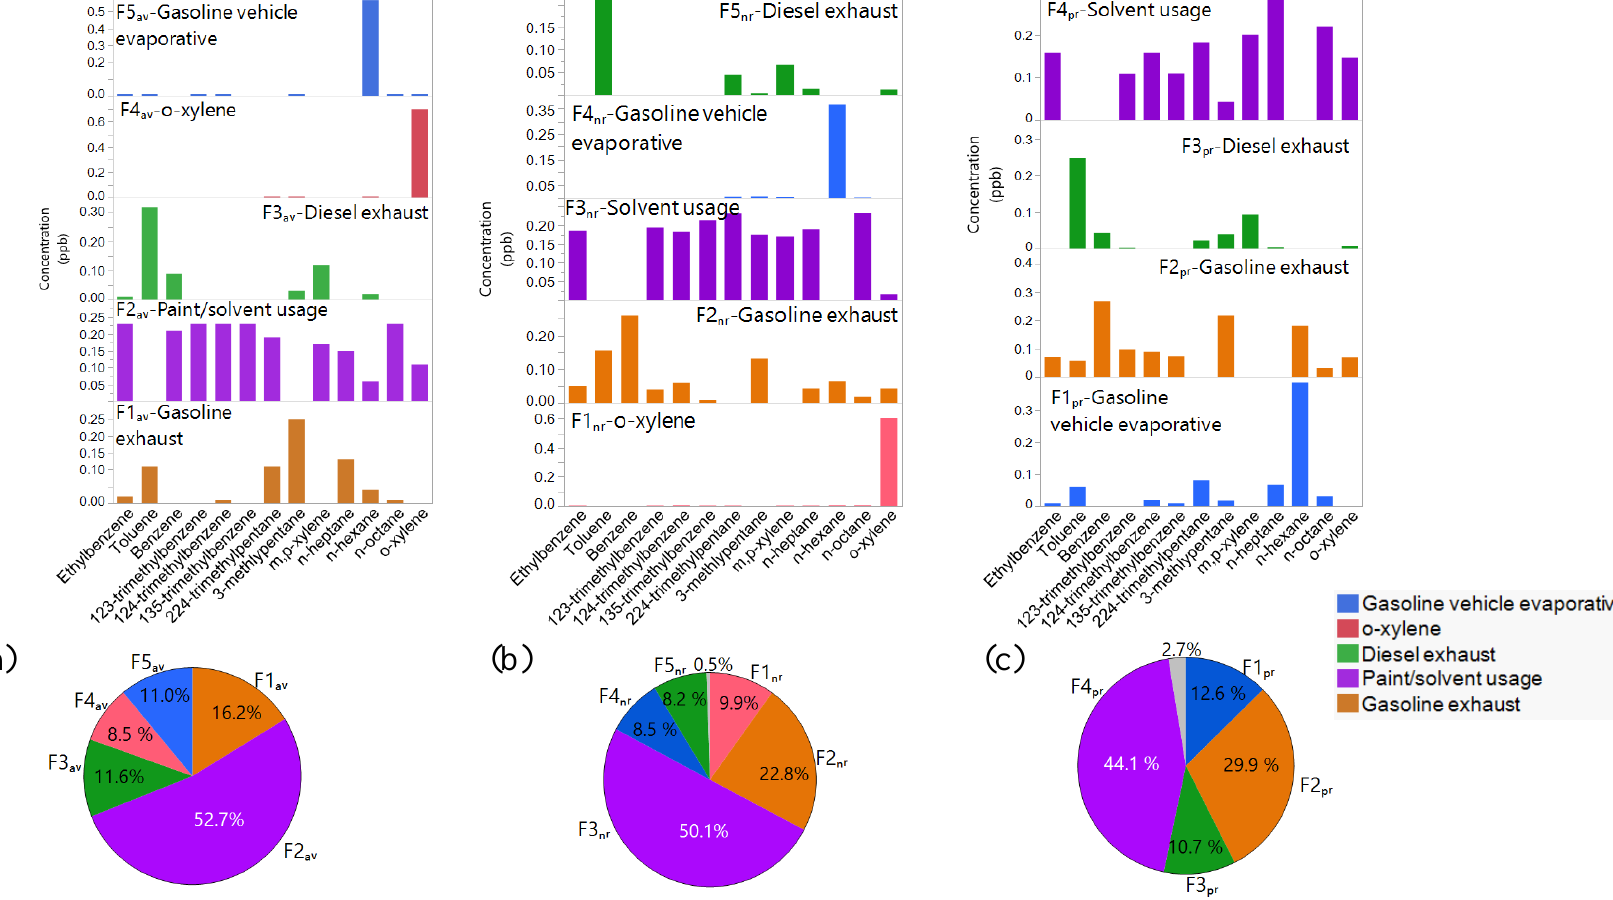
Figure 7. Concentration source profile and average VOC molar contribution of PMF factors retained at community monitors in: Atchison Village ( a ); North Richmond ( b ); and Point Richmond ( c ). Unexplained molar fraction at Atchison Village was below